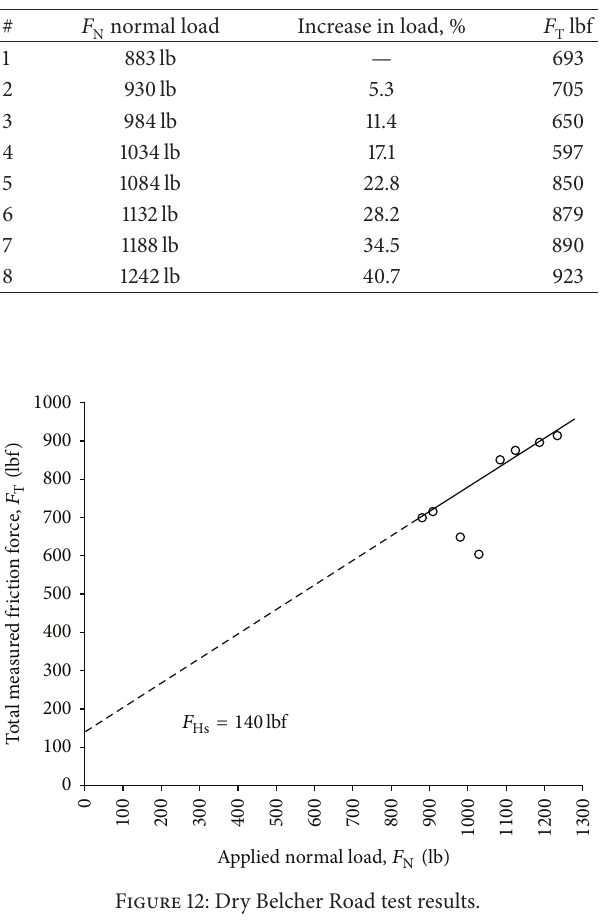
Table 3: Individual weights selected for use in controlling the ) applied to test tire during lockups and measured dynamic load ( 𝐹 N 𝐹 values wet asphalt pavement testing. T